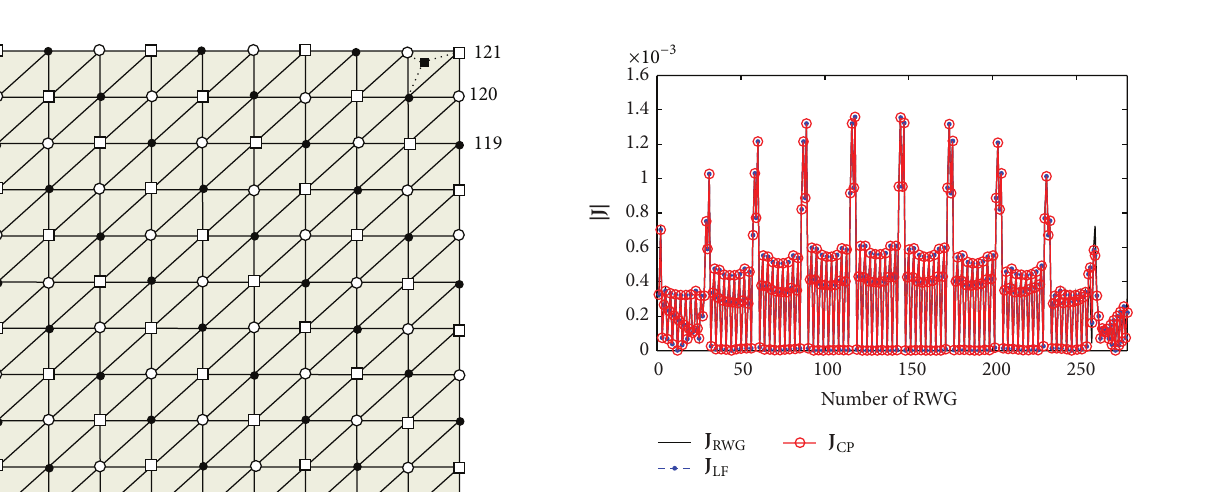
Figure 11: Surface currents on the PEC plate (expansion coefficients of the RWG basis functions).